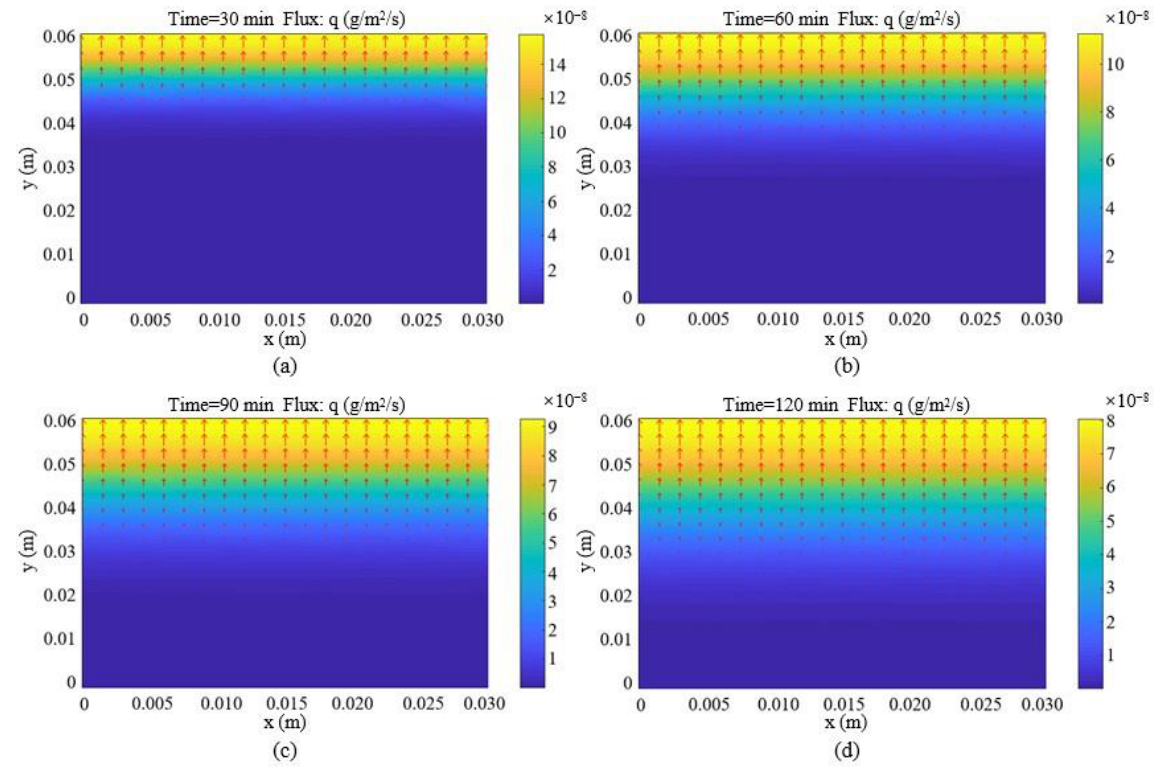
Figure 14. Two-dimensional cloud images of benzothiazole diffusion in CRMB binder at ( a ) 30 min, ( b ) 60 min, ( c ) 90 min, and ( d ) 120 min. ( b ) 60 min, ( c ) 90 min, and ( d ) 120